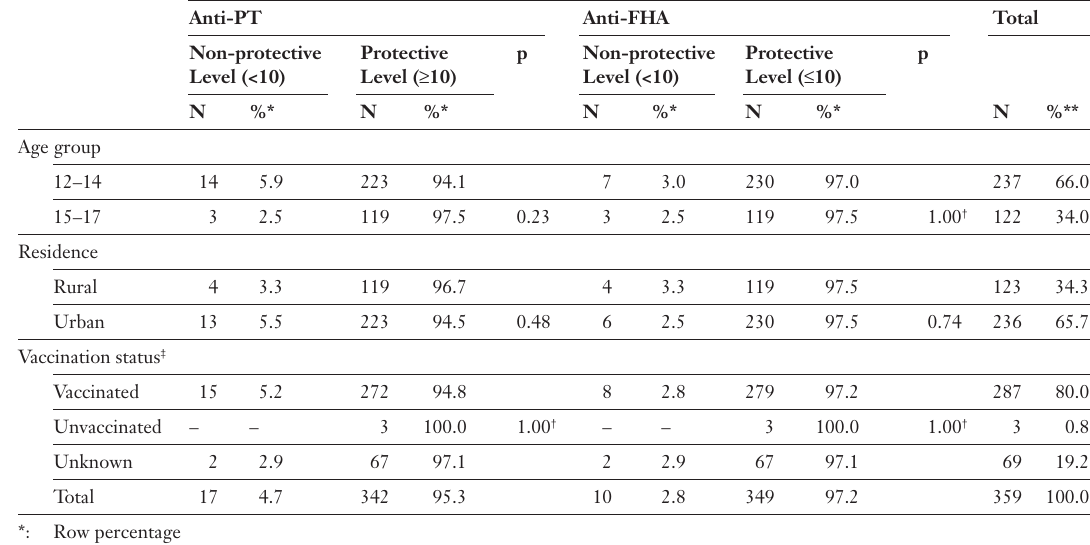
Anti-PT and anti- FHA antibody levels according to age, residence and vacci- nation status (Edirne,